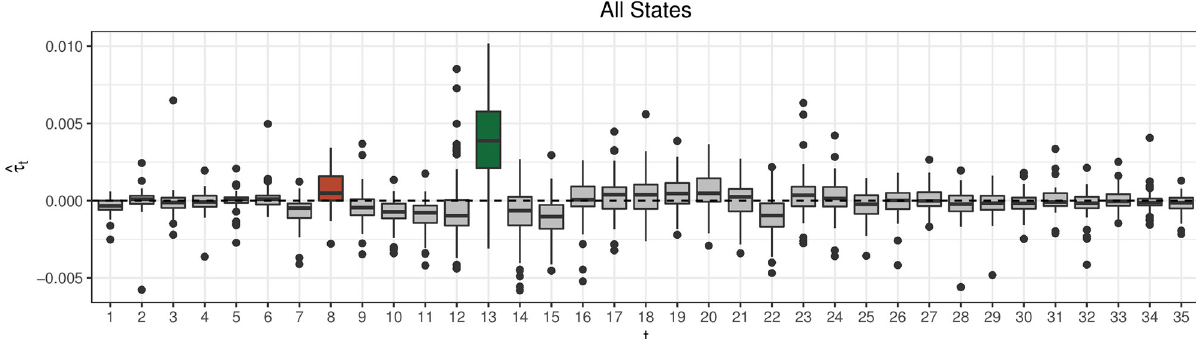
across all states for each week t . ^ t the week of Thanksgiving (brown) and Christmas (green) are t t